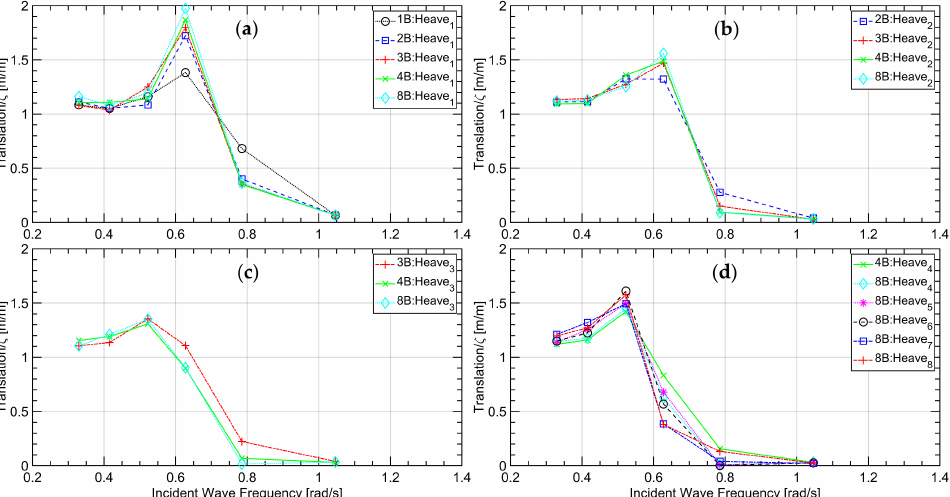
Figure 7. RAOs of heave response of the five test cases for the chain configuration, where n B denotes the configuration with n bodies; subscript n , the corresponding n -th body’s motion response: ( a ) the 1st module; ( b ) the 2nd module; ( c ) the 3rd module; ( d ) the 4th–8th